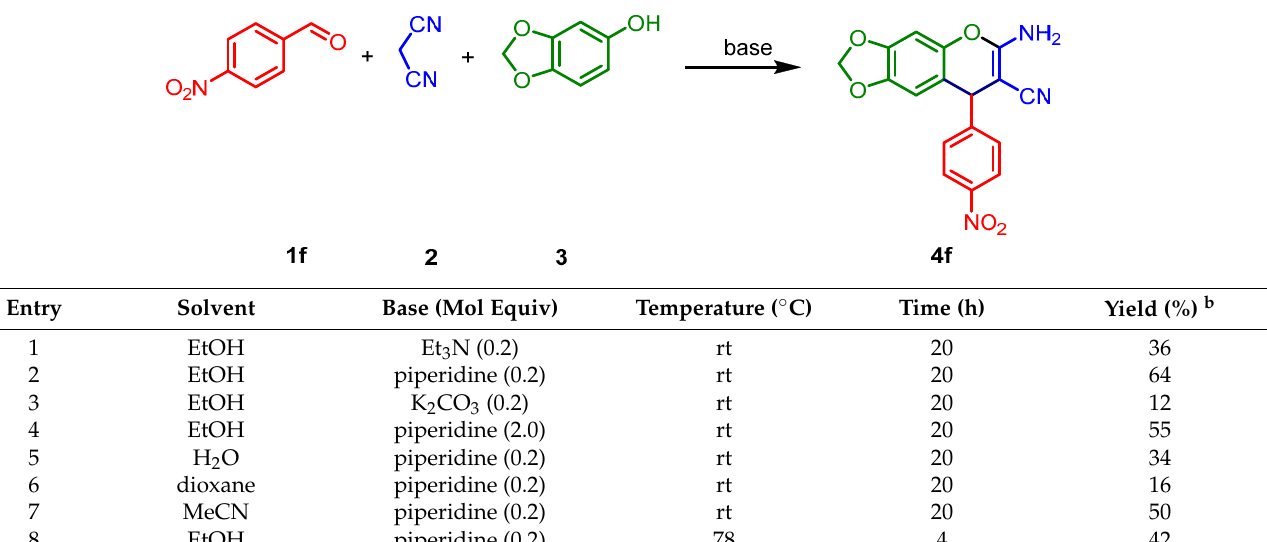
Table 1. Optimization of the reaction conditions for the synthesis of 2-amino-3-cyano-6,7-methylendioxy-4-(4-nitrophenyl)-4 H -chromene 4f a .